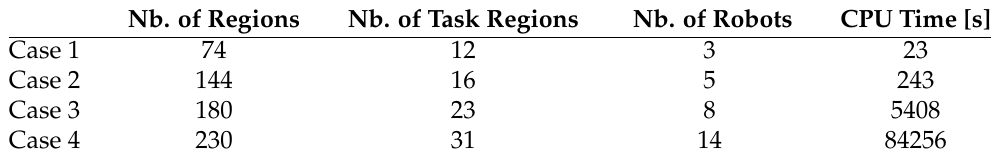
Table 3. Simulation results for different cases. Nb. of Regions Nb. of Task Regions Nb. of Robots CPU Time